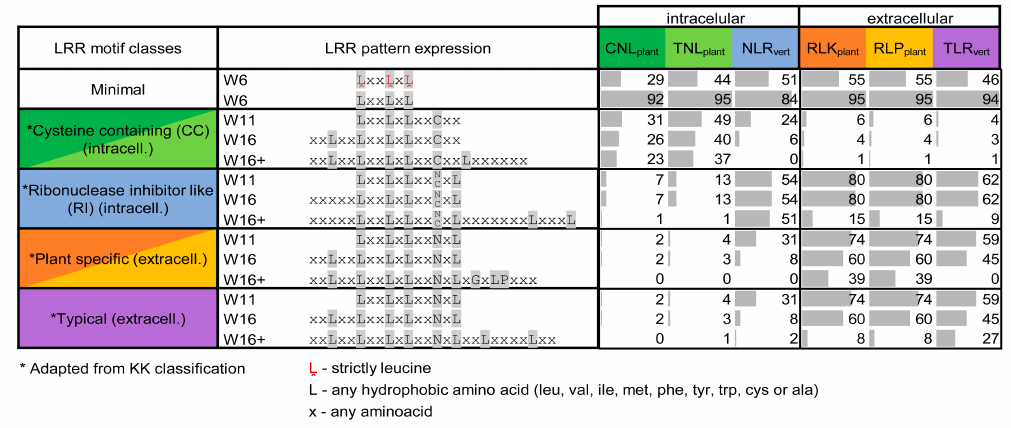
Figure 6. Distribution of LRR motif types defined by Kobe and Kajava (KK) [14] predicted with LRRpredictor across the six receptor classes. As the motif consensuses from KK classification were very strict, we adapted these consensuses to different sequences windows (W6, W11, W16, or more) centered around the minimal motif as shown in the table. Percentages of the predicted motifs compatible with each consensus are shown with grey bars.